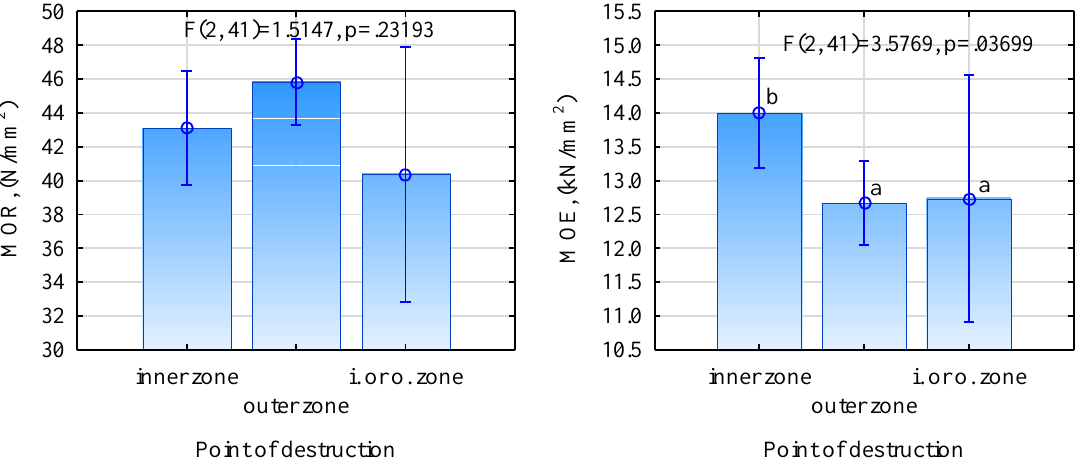
Figure 9. ANOVA of the assessment of the static bending strength and modulus of elasticity relative to the point of destruction (Letters mark uniform groups determined with the Tukey HSD test).